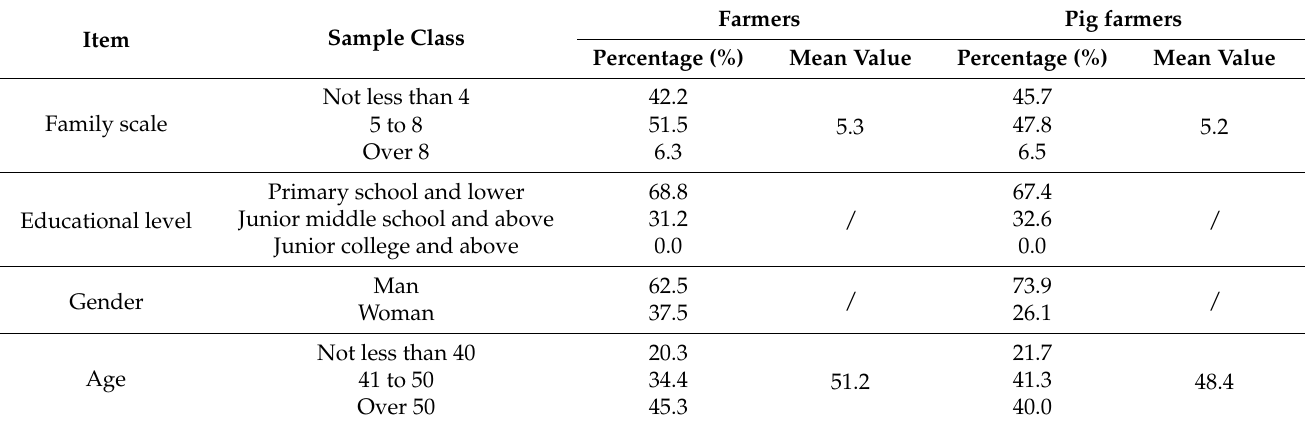
Table 1. The scale of each